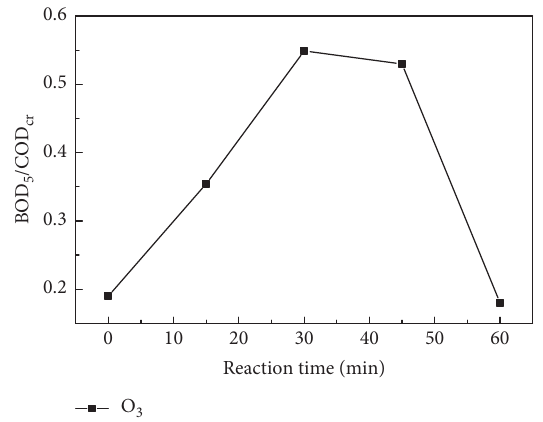
Figure 7: Effect of O 3 oxidation on biodegradability of wastewater.